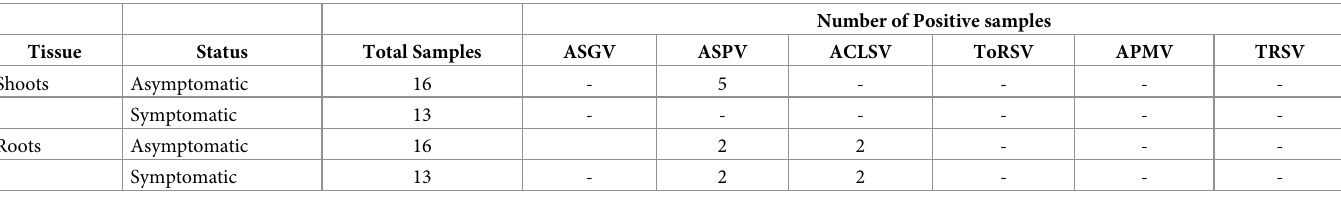
mosaic virus, and TRSV = Tobacco ringspot